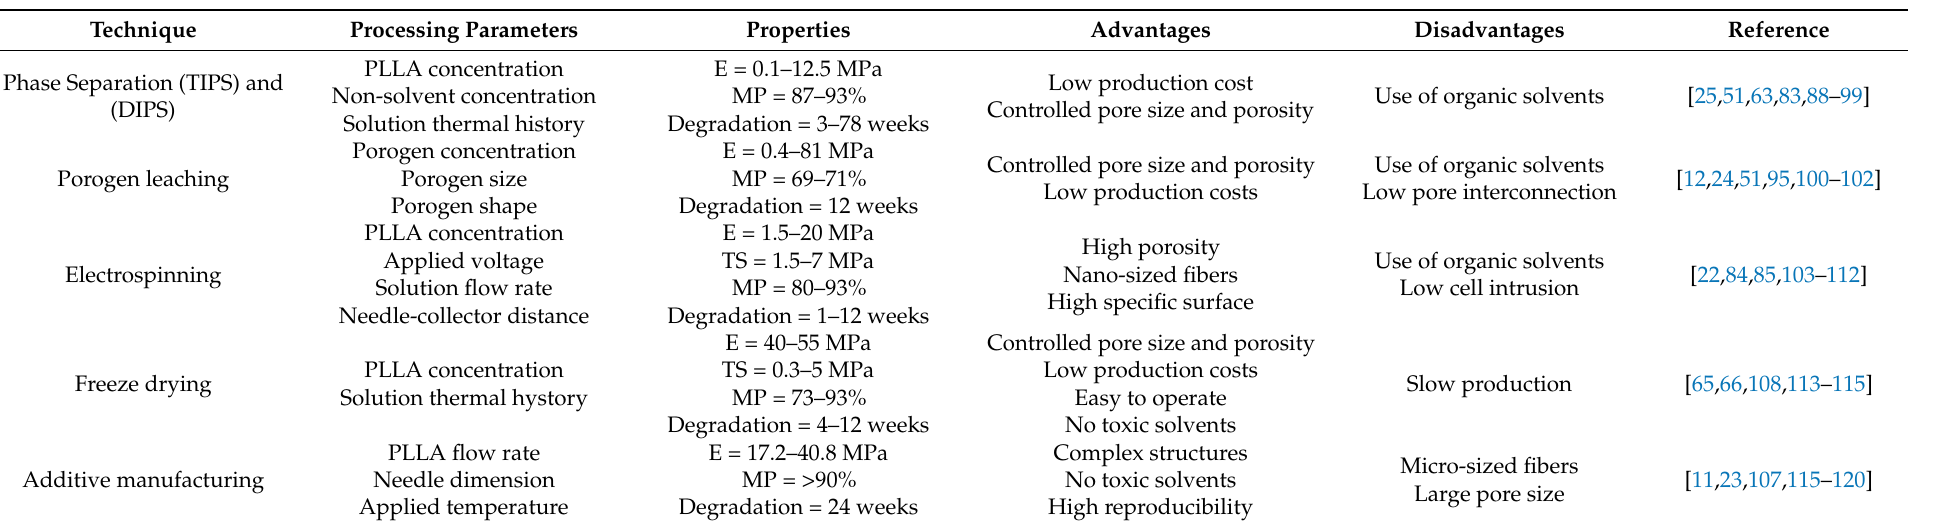
Table 1. Fabrication techniques used for producing PLLA-based